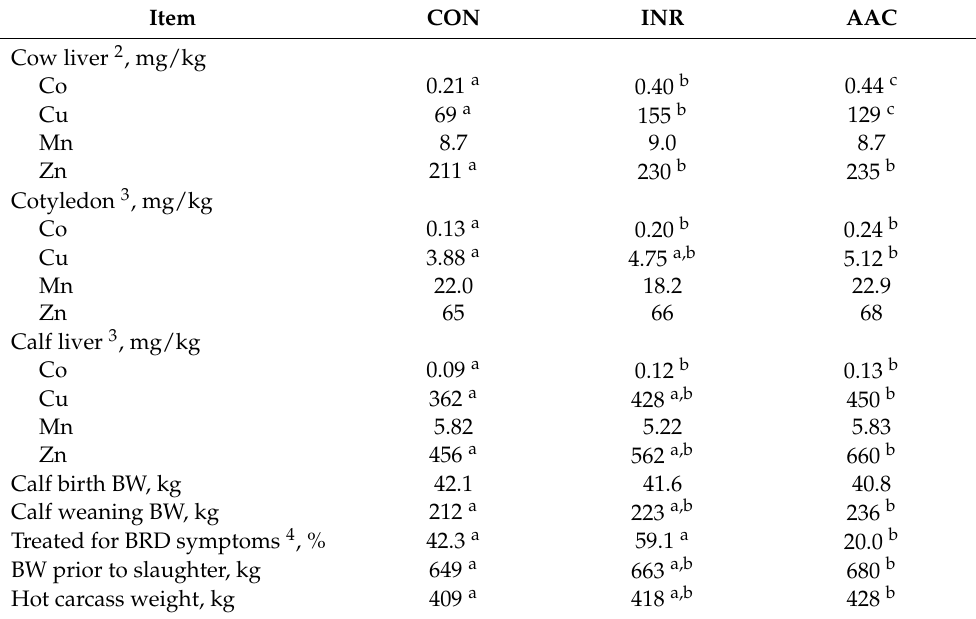
Table 1. Physiological, health, and productive responses from beef cows (and their offspring) that received diets containing no supplemental Cu, Co, Mn, and Zn (CON); sulfate sources of Cu, Co, Mn, and Zn (INR); or organic complexed source of Cu, Mn, Co, and Zn (AAC) during the last trimester of gestation 1 . Item CON INR AAC Cow liver 2 , mg/kg Co 0.21